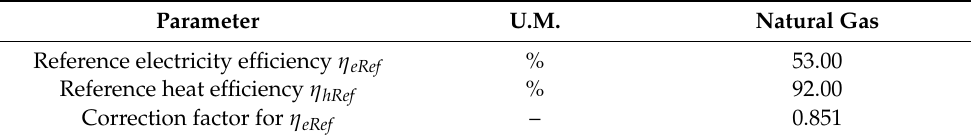
Table 2. Efficiency reference values for separate production of electricity and heat